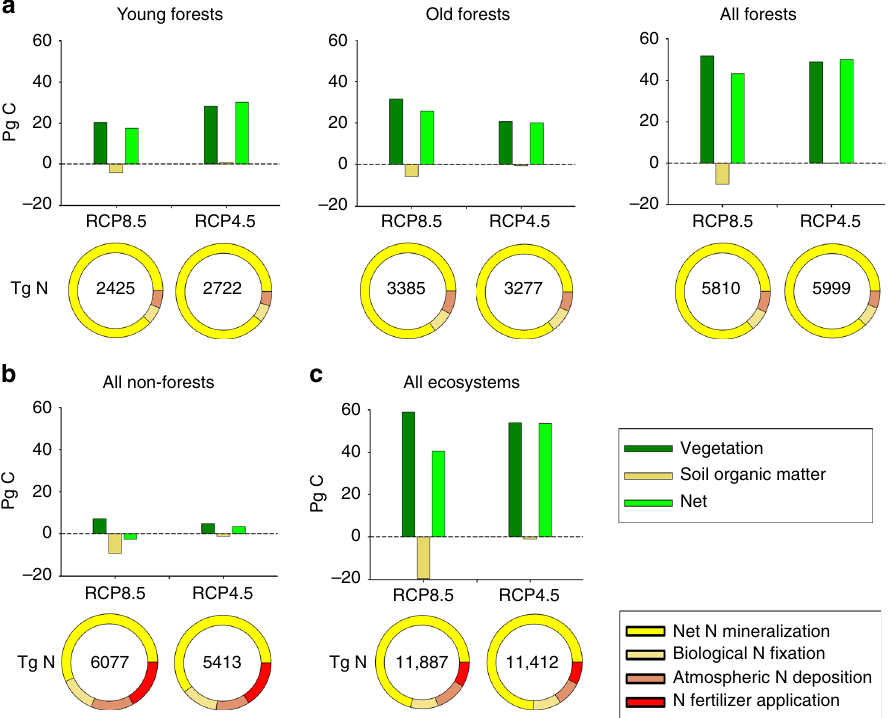
Fig. 3 Characteristics of future C sequestration and N availability for Northern Eurasian ecosystems under the RCP8.5 and RCP4.5 scenarios. a Forest ecosystems include young forests (stand age <120-years-old) and old forests (stand age at least 120-years-old). b Non-forested ecosystems (combination of tundra, grasslands, shrublands, deserts, wetlands, croplands, and pastures). c All ecosystems. Positive values in the graphs represent cumulative C sequestration over the 21st century and negative values represent C losses. Circles represent the partitioning of N availability among net N mineralization, biological N fi xation, atmospheric N deposition and N fertilizer application. Values within circles represent total N availability over the 21st